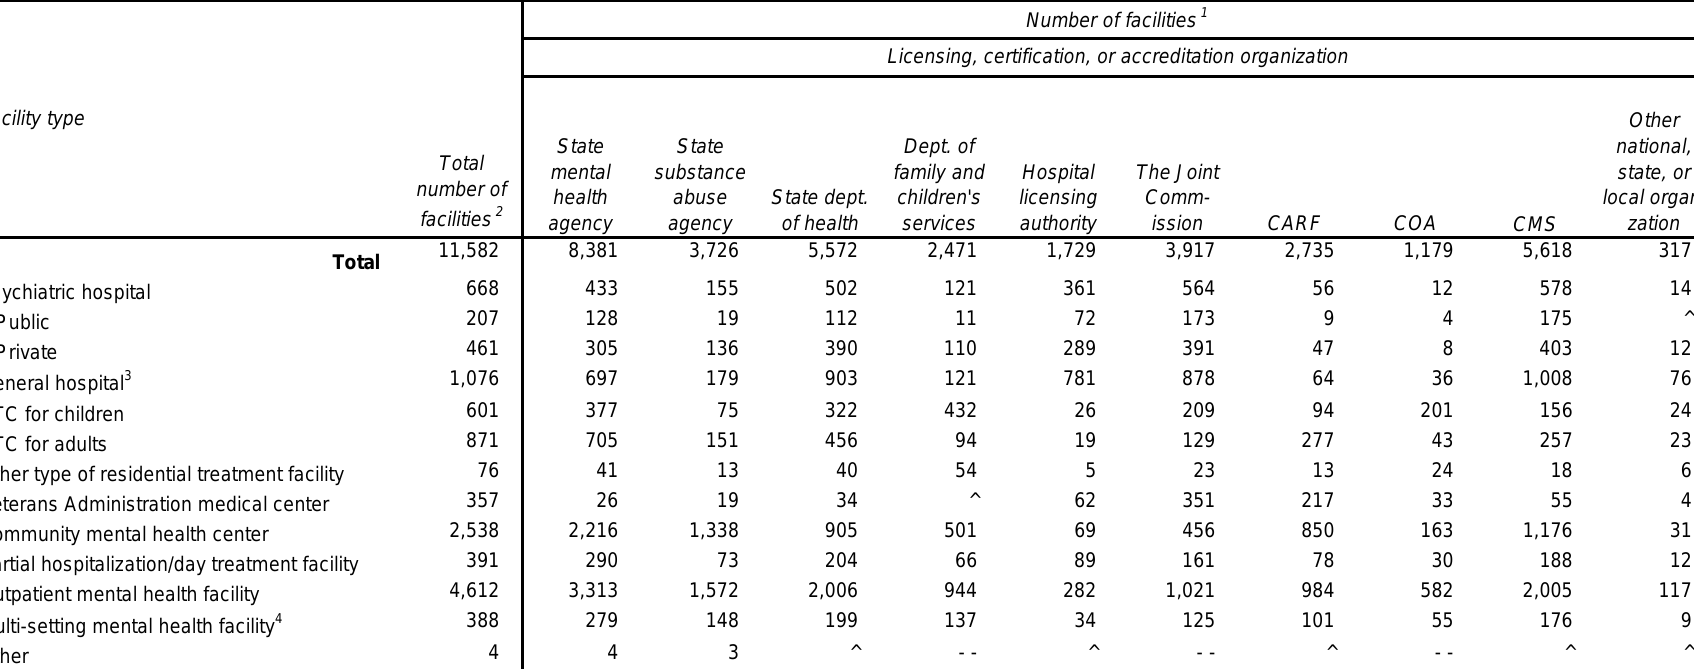
Table 2.11a. Mental health treatment facility licensing, certification, or accreditation, by facility type: Number,